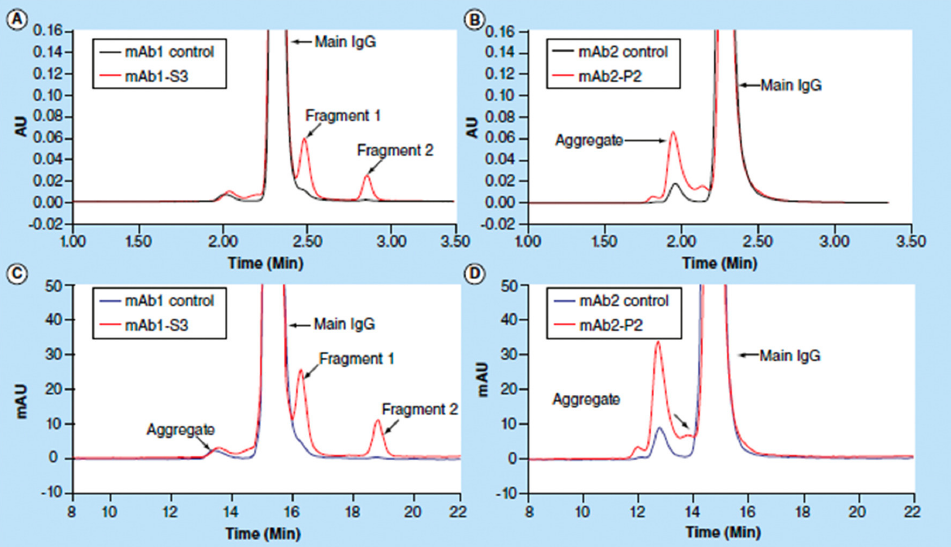
Figure 15. Size-exclusion chromatography ( SEC) analyses of control monoclonal antibodies mAb1 and mAb2, antibody mAb1 after thermal stability studies for 3 months and an in-process antibody mAb2. Chromatograms ( A , B ) were obtained using UHPLC (ultra high-performance liquid chro- matography), whereas chromatograms ( C , D ) were obtained by HPLC. Reproduced with permission from [185], Elsevier, 2018.